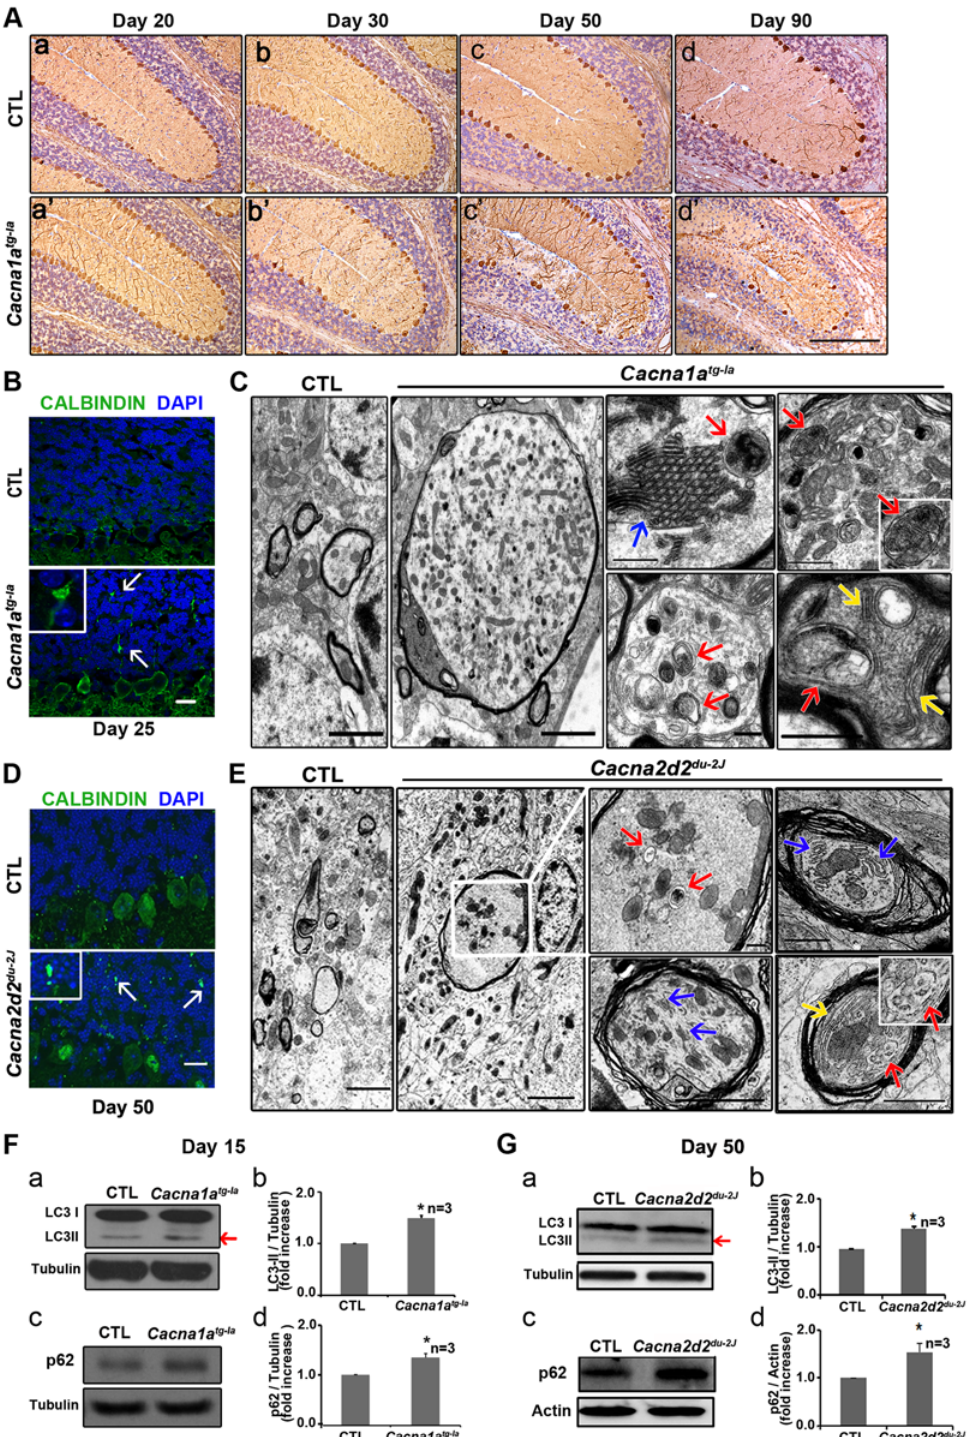
Fig 4. Cacna1a tg-la and Cacna2d2 du-2J mice have autophagy defects. A. Calbindin and hematoxylin staining of mice cerebella indicates that Cacna1a tg-la mice have progressive PC and granule cell loss upon aging. Scale bar, 200 μ m. B, D. Calbindin (green) and 4',6-diamidino-2-phenylindole (DAPI)(blue) staining of mice cerebellum indicates that there are swollen PC axons (arrows) in the granular layers of the Cacna1a tg-la mice cerebellum at day 25 (B) and the Cacna2d2 du-2J mice at day 50 (D). Scale bar, 20 μ m. C, E. The TEM of the axons at the granular layers of the cerebellum showing that many PC axons in Cacna1a tg-la and Cacna2d2 du-2J mice are swollen and accumulated with numerous mitochondria, autophagosome/MVBs-like structures (red arrows), and